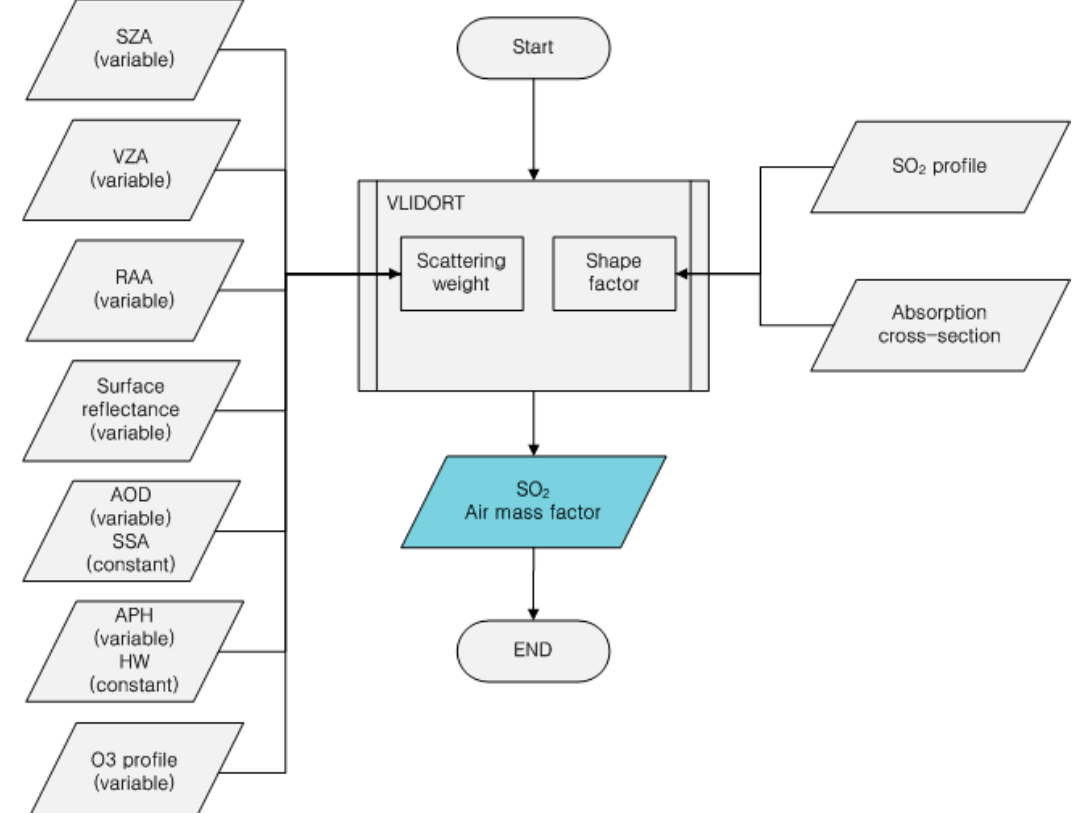
Figure 1. Flow chart of SO 2 air mass factor (AMF) calculation.